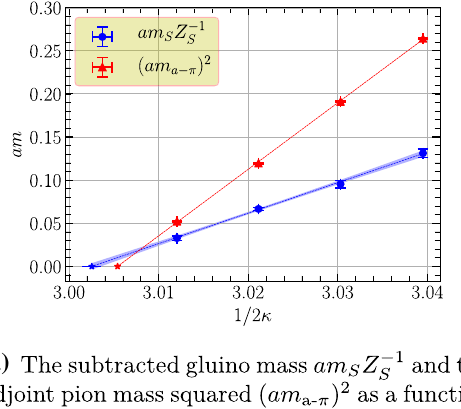
Fig. 2 Chiral limit and determination of the remnant gluino mass at β = 5 . 6. All quantities are in lattice units Table 3 The values of the remnant gluino mass − 1 (cid:17)( am ) obtained at four S Z S different values of the inverse gauge coupling